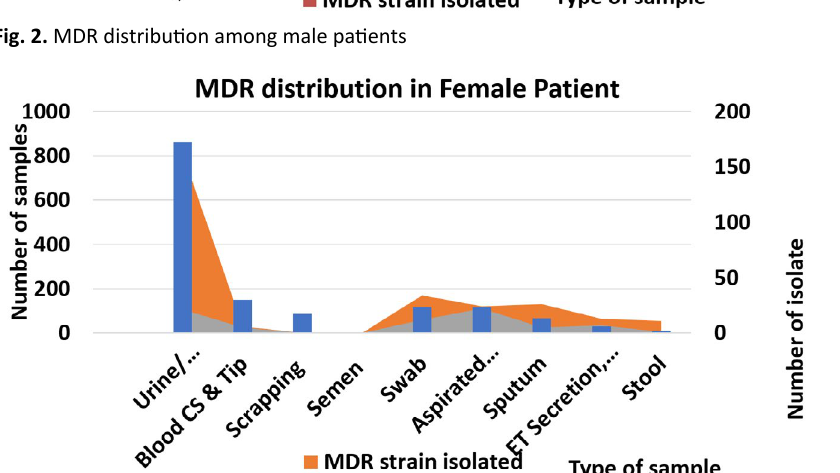
Fig. 3. MDR distribution among female